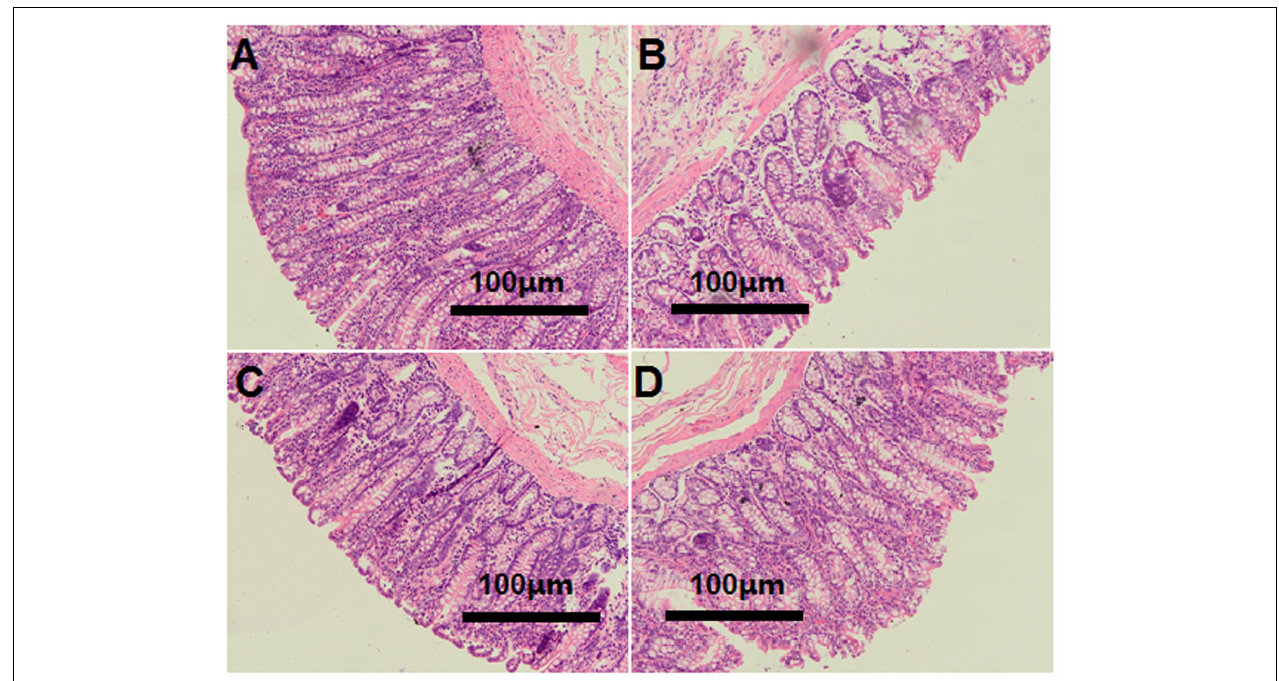
FIGURE 3 | Histology of colon tissue, comparing hay-fed and a high grain (HG) diet-fed sheep. Light microscopy cross-section of colon tissue in the CON ( A , scale bar = 100 µ m), HG7 ( B , scale bar = 100 µ m), HG14 ( C , scale bar = 100 µ m), HG28 ( D , scale bar = 100 µ m).